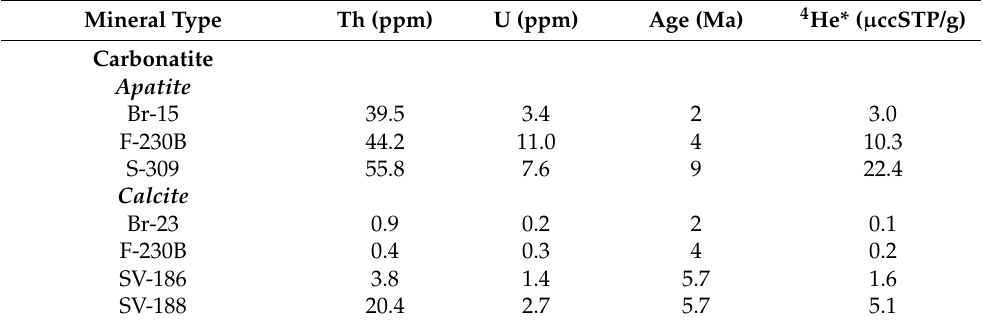
Table A4. Th and U concentrations and related 4He* production in mineral separates from Cape Verde carbonatites.